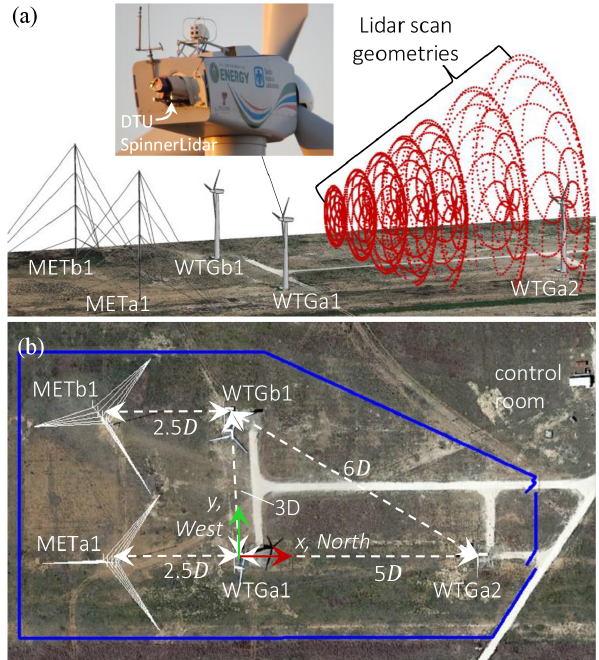
Figure 2. (a) Rendering of the SWiFT facility in Lubbock, Texas, USA. The nacelle of WTGa1 was outfitted with a rear-mounted DTU SpinnerLidar, which scanned the flow at different focus lengths according to the rosette patterns shown in red. Rendering from Doubrawa et al. (2020). (b) Planform view of the site where D = 27m. Adapted from Herges and Keyantuo